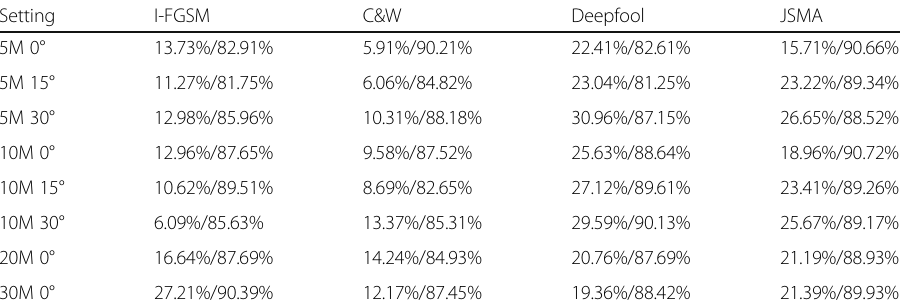
Table 2 Top-1 classification accuracy under the poster-printing attack scenario (M means meter, º means angel. The former is the accuracy of the target model, the latter is the accuracy of the defense